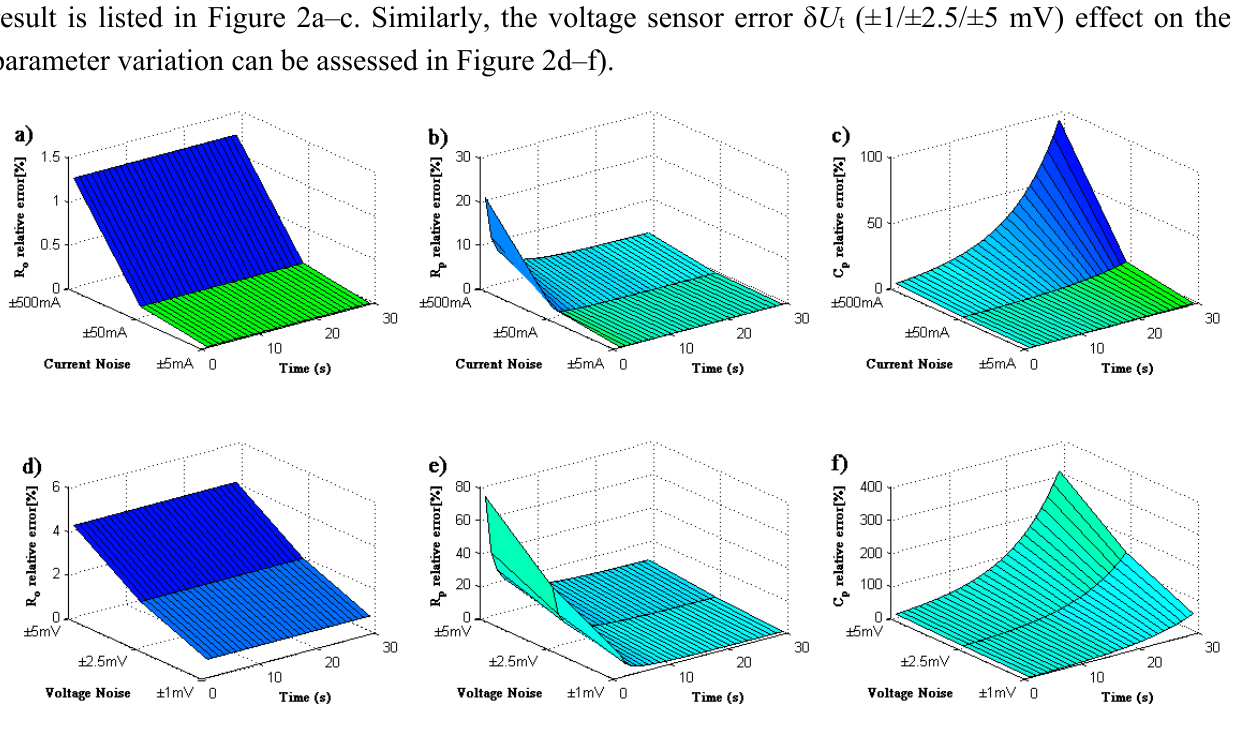
Figure 2. Relative errors of model parameters: ( a ) R o , ( b ) R p , ( c ) C p under current noises; and ( d ) R o , ( e ) R p , ( f ) C p under voltage